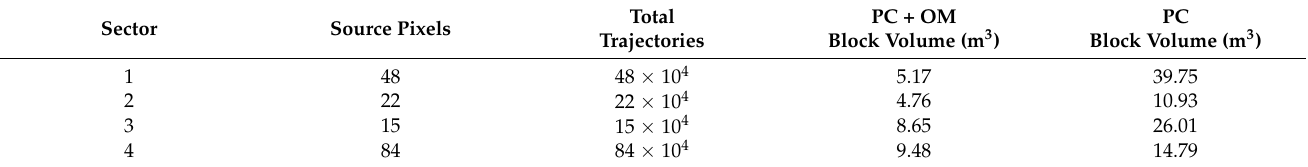
Table 5. Simulation characteristics for each source area, with 10,000 trajectories simulated per source pixel. Sector Source